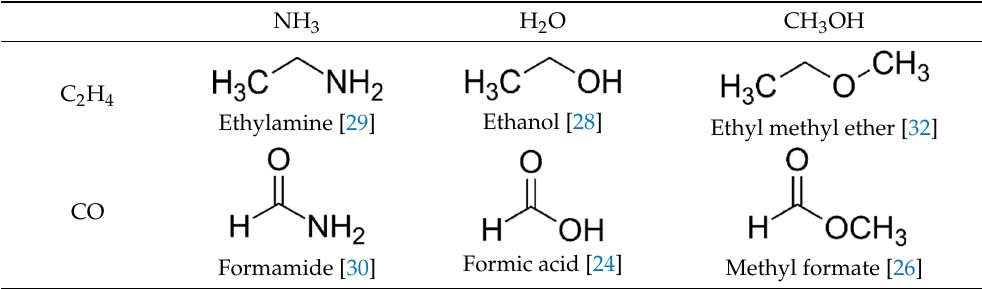
Table 1. Products that can be formed in reactions of C 2 H 4 and CO with NH 3 , H 2 O, and CH 3 OH when electron interaction leads to addition of one reactant to the other so that all atoms of the initial reactants become incorporated in the product. Such reactions are also referred to as atom-efficient. The products shown here are those that are formed with the smallest possible number of bonds being broken and reformed as compared to the reactants.